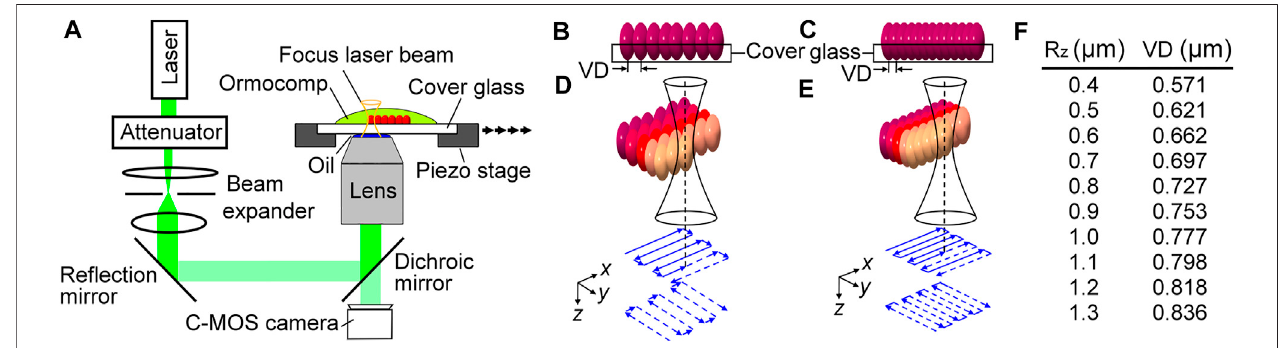
FIGURE1| IllustrationsoftheTPPsetup (A) ,substrateswithhighsurfaceroughnessusingalargevoxeldistance (B) andlowsurfaceroughnessusingasmallvoxel distance (C) , route patterns of raster programs designed for high (D) and low surface roughness, and a list of quanti fi ed correlations between R z and low surface roughness (E) , and a list of quanti fi ed correlations between R z and voxel distances (F)